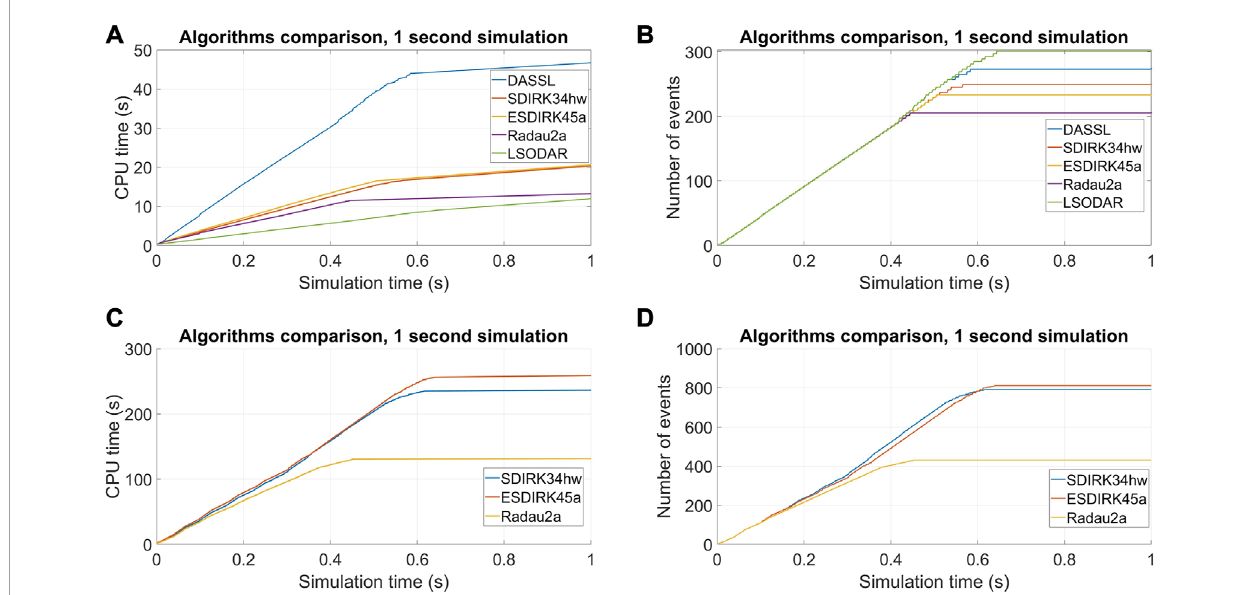
FIGURE 7 1-s simulation results for different numerical integration algorithms, adiabatic model CPU time (A) , adiabatic model number of events (B) , model with heat losses CPU time (C) , and model with heat losses number of events (D) .